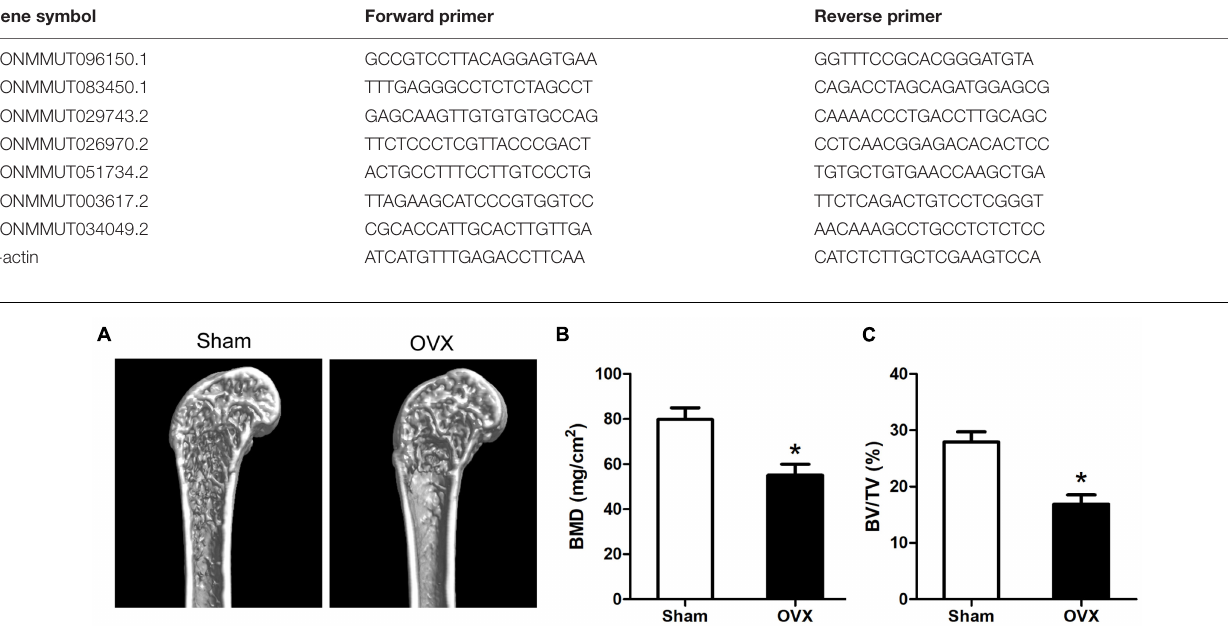
FIGURE 1 | Evaluation of the OVX mouse model. (A) The 3D micro-CT images of the distal and middle femurs. (B) OVX mice had lower BMD as compared to the controls. (C) BV/TV of femurs were measured by micro-CT. * p < 0.05 vs Sham